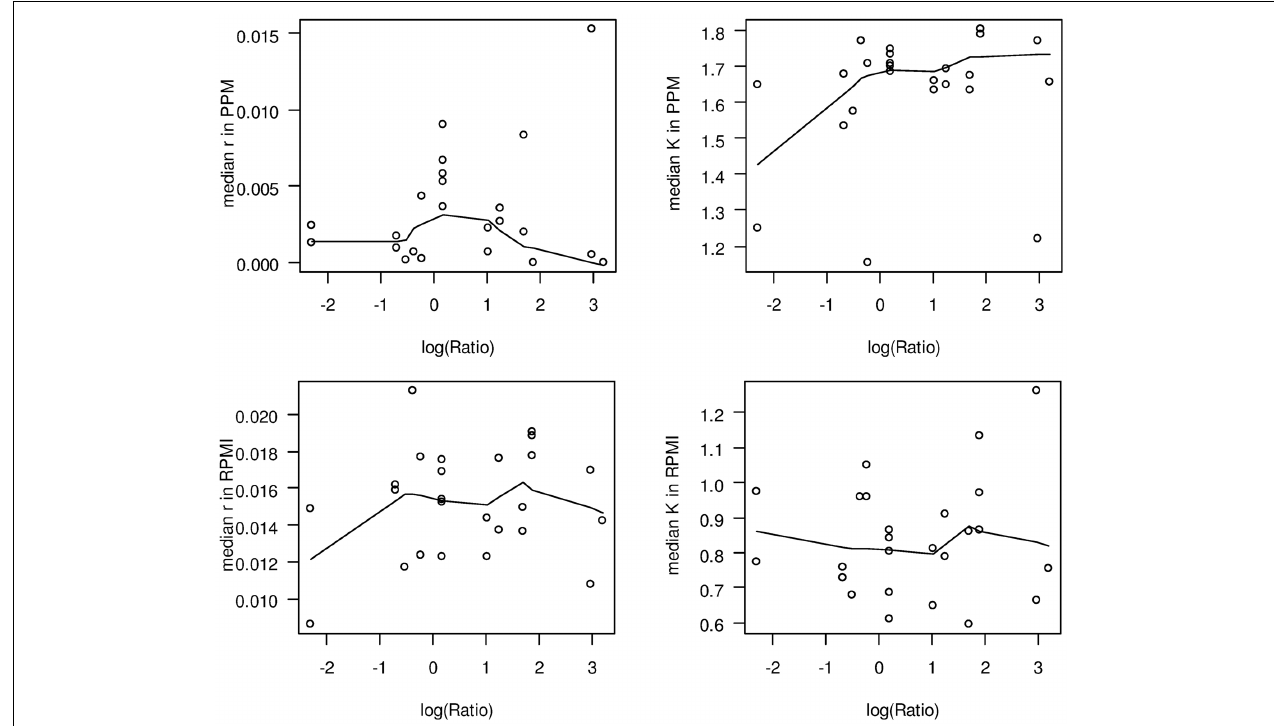
FIGURE 5 | Scatter plots comparing in vitro growth parameters and carriage/disease ratios. In each panel, the logarithm of the corresponding carriage/disease ratio is depicted for each clonal complex on the abscissa. The solid lines in each plot give a locally weighted scatter plot smoothing of the respective data. The ratios have been taken from Caugant and Maiden (2009) and are based on data deposited in the PubMLST database, which